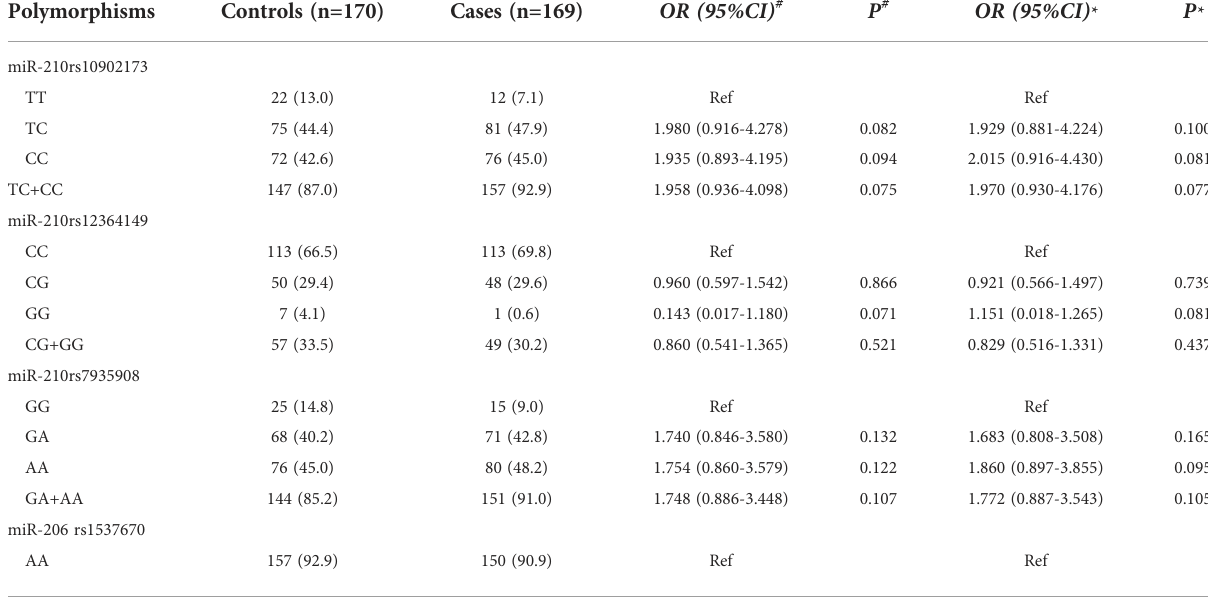
TABLE 5 The miRNA genetic polymorphisms and the risk of soft tissue